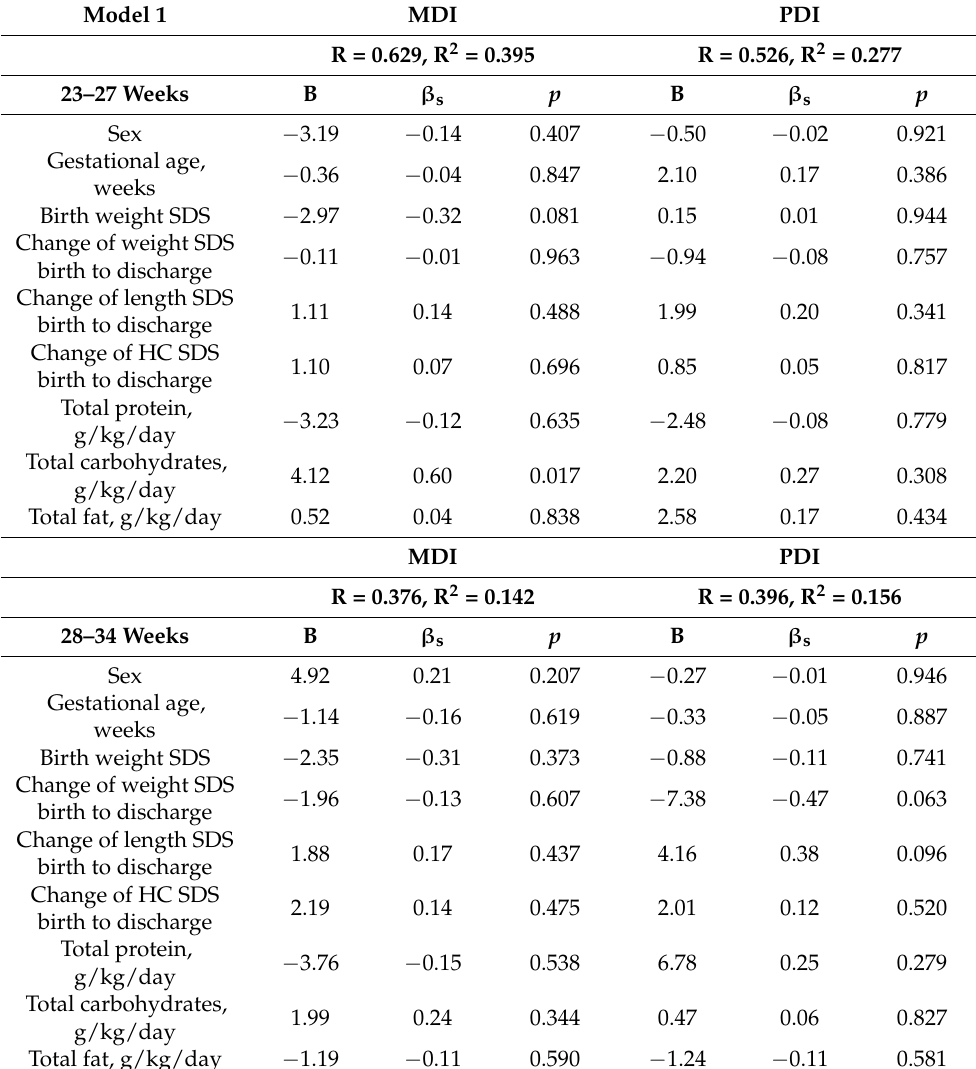
Table 4. Relationship between growth during hospitalization period, average daily total nutrient intake during first 28 days, and neurodevelopment at 12 months of